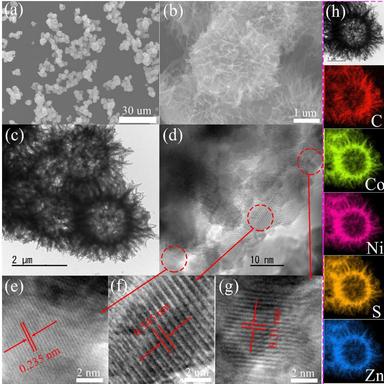
FESEM images of (a, b) CoNiZnS/C-2. Low-magnification TEM image (c) and HRTEM images (d), (e), (f), (g) of CoNiZnS/C-2. (h) EDS elemental mappings of CoNiZnS/C-2 including C, Co, Ni, S, and Zn elements.